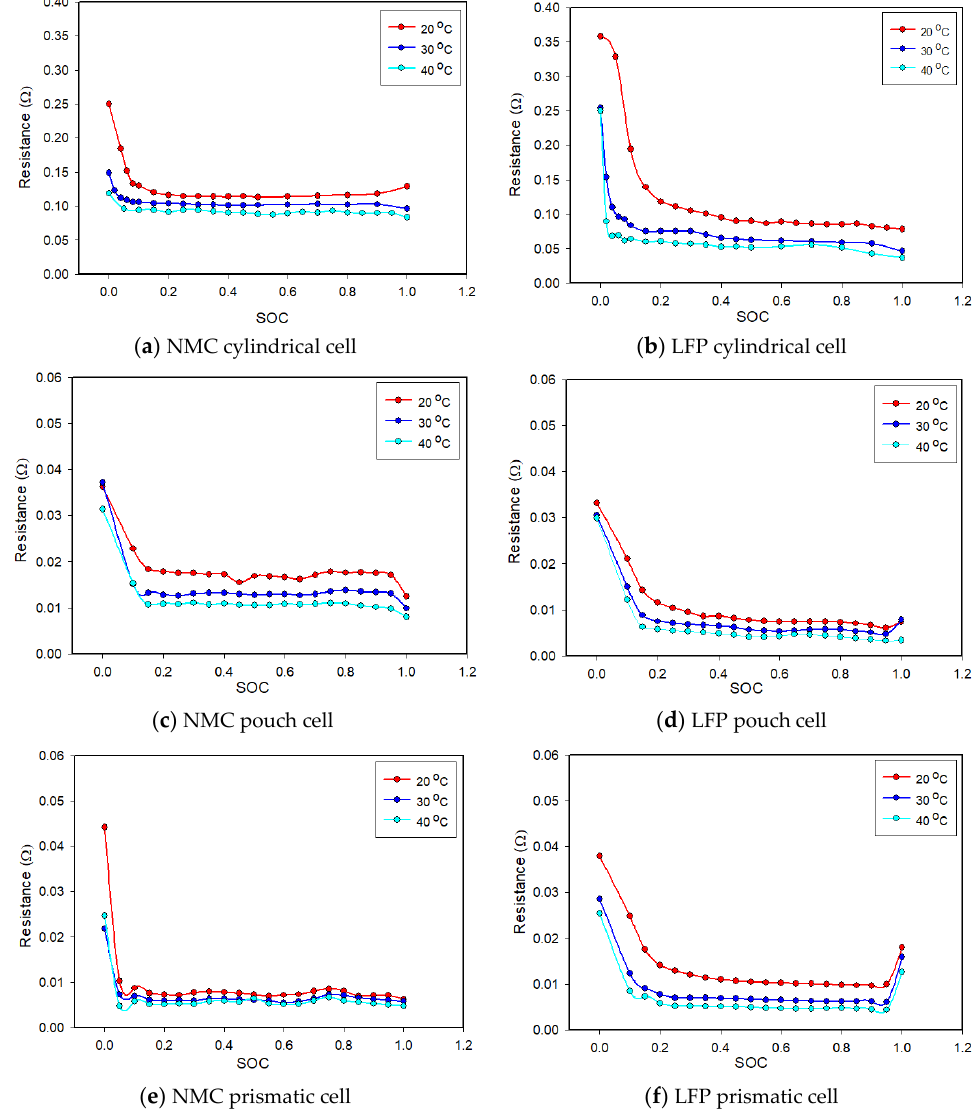
Figure 6. Internal resistance of the experimental batteries: ( a ) NMC cylindrical, ( b ) LFP cylindrical, ( c ) NMC pouch, ( d ) LFP pouch, ( e ) NMC prismatic, and ( f ) LFP